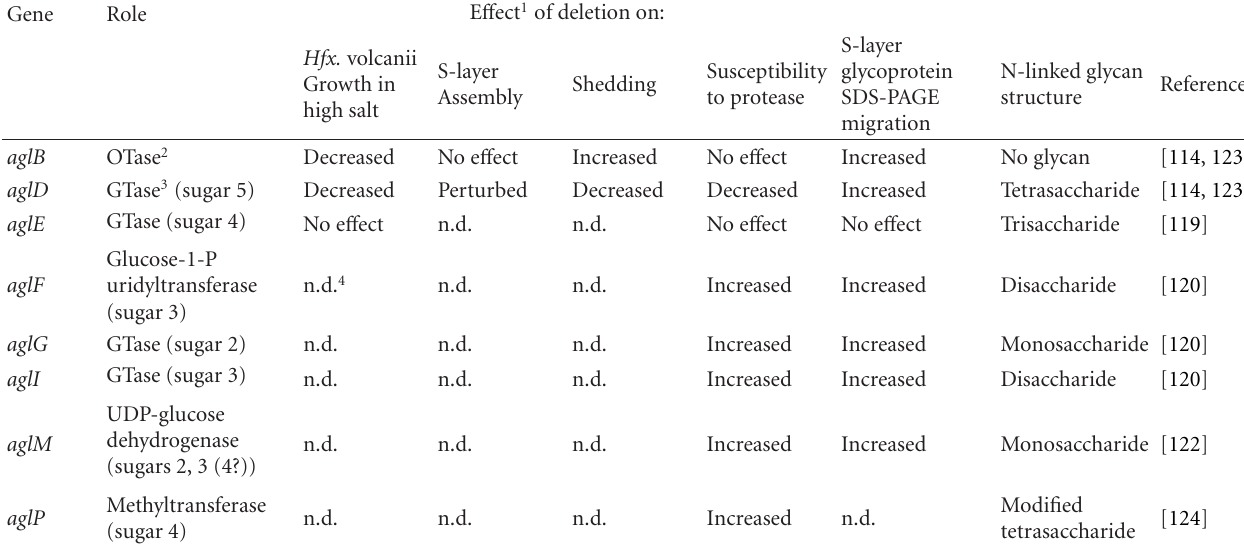
Table 1: E ff ects of Hfx. volcanii agl